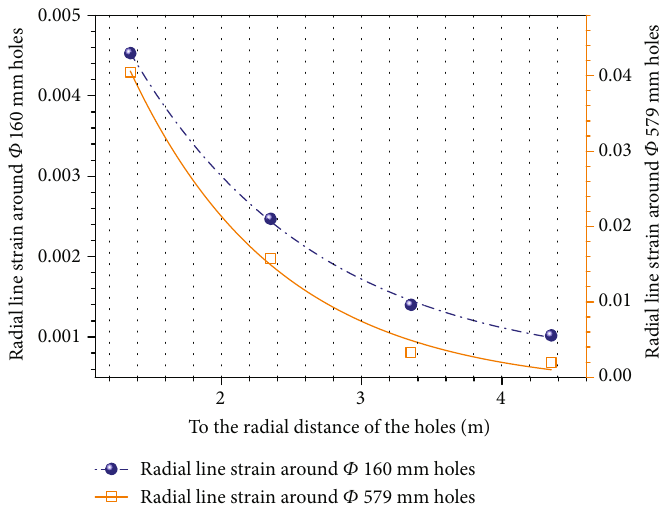
Figure 11: Radial line strain distribution of coal around borehole according to onsite measurement with FBG.